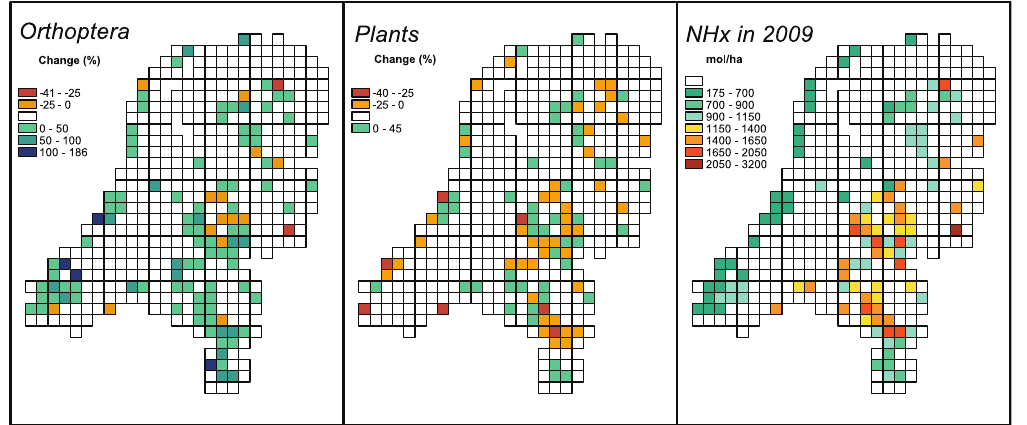
Figure 1. Changes in Orthoptera- and plant species richness between P2 and P3. Ammonia deposition in 2009. Plant species richness and ammonia deposition are only shown for those 10 by 10 km grid cells that met the criteria for Orthoptera data availability (see table